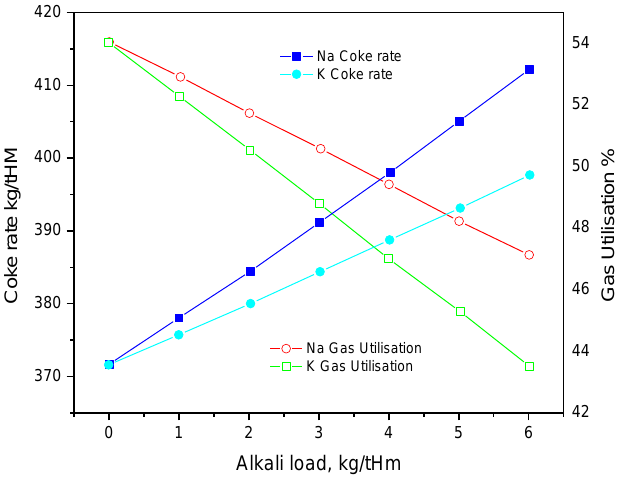
Figure 4. Variation of the coke rate under various Na 2 O and K 2 O loads.